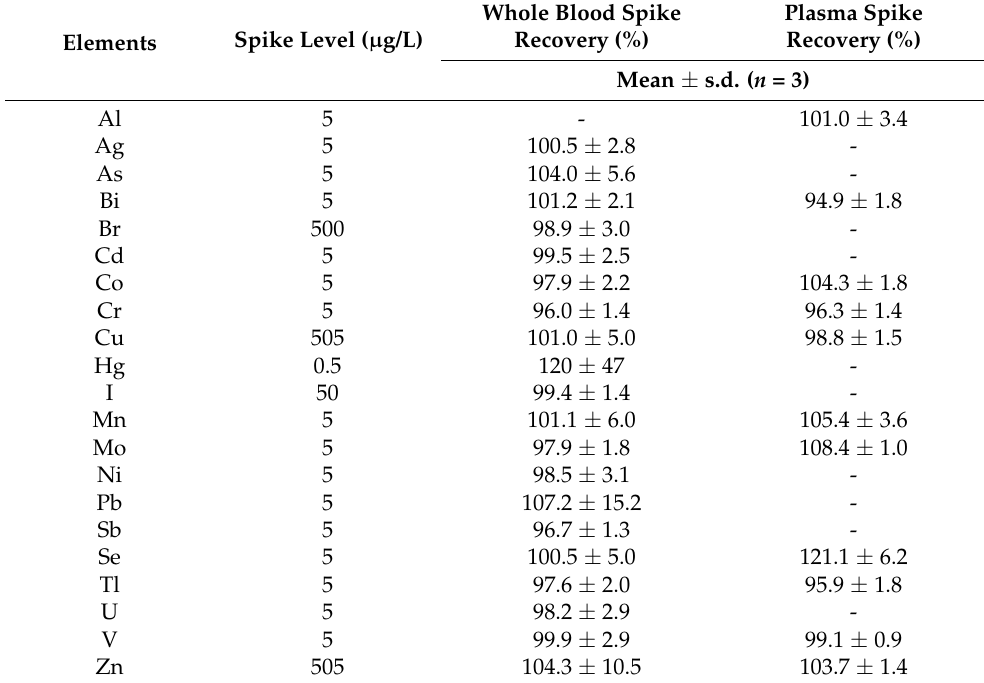
Table 4. Spike recoveries of elements from whole blood and plasma.